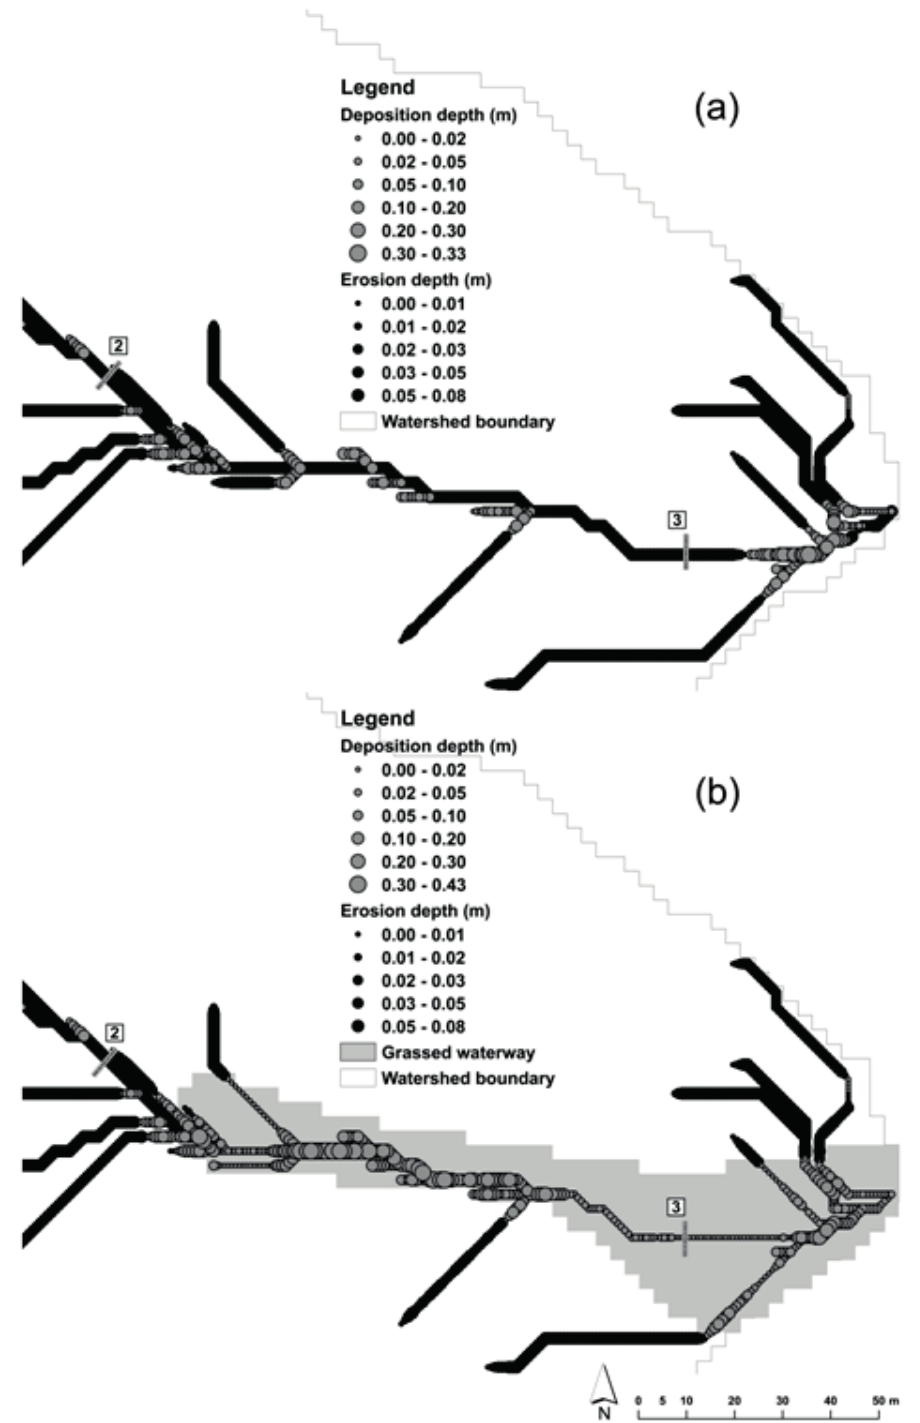
Fig. 4 Channel erosion and deposition depths (m) predicted: (a) without a grassed waterway, indicating deposition was mainly in backwater areas at tributary confluences, and (b) with a grassed waterway showing additional deposition within the grassed